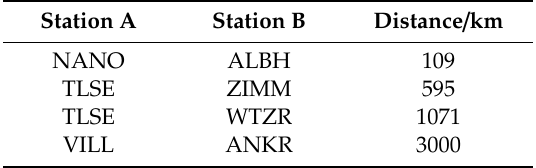
Figure 4. Geographical distribution of the International GNSS Service (IGS) stations. Table 1. The information of Common View (CV) stations.